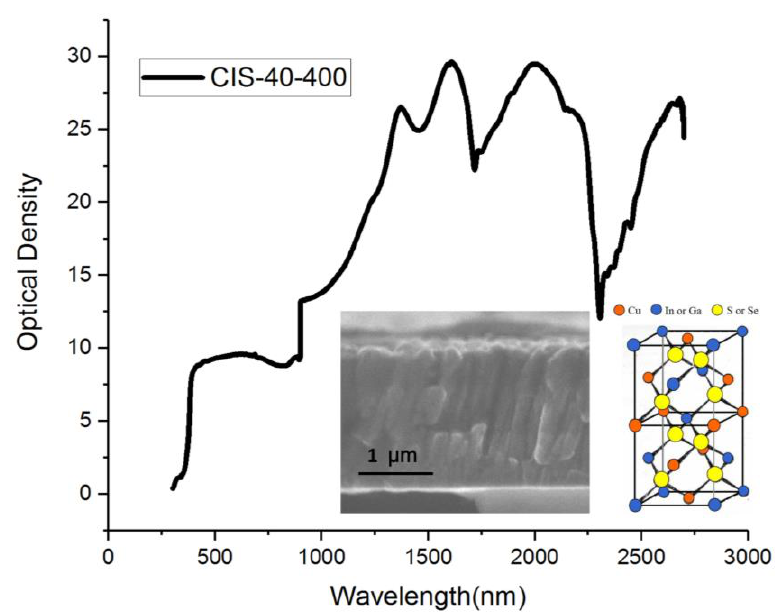
Figure 7. A filter with a bandpass wavelength of 1000–2300 nm was placed in front of each imaging system to eliminate ambient light.